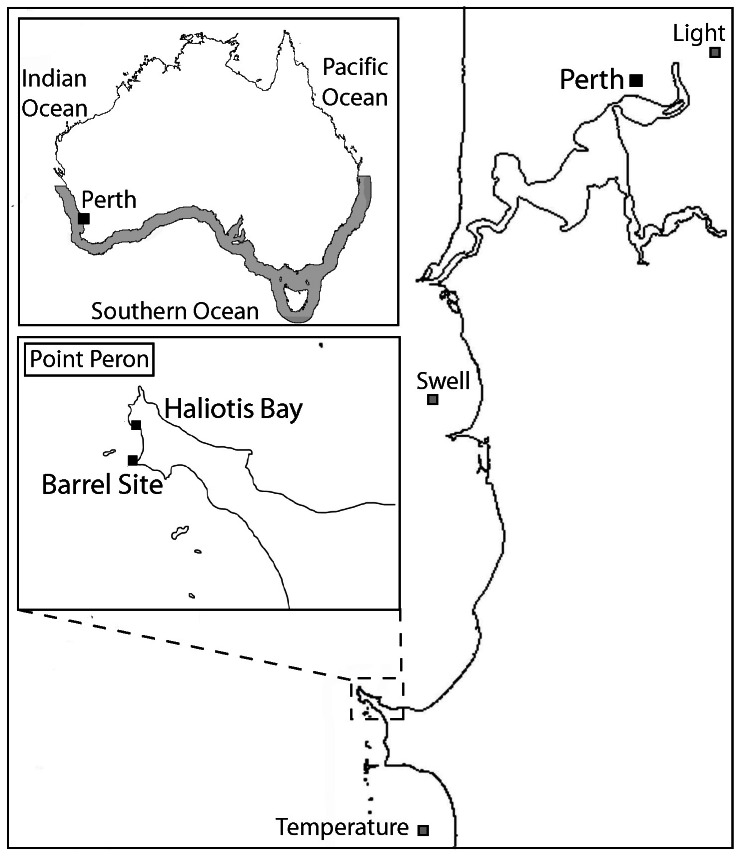
Collection sites for two-weekly zoospore counts and growth experiment.Main map - Perth region, Western Australia; Upper Inset – Australia map showing oceans and distribution of Ecklonia radiata in grey; Lower Inset - Point Peron, displaying Barrel Site and Haliotis Bay collection sites.